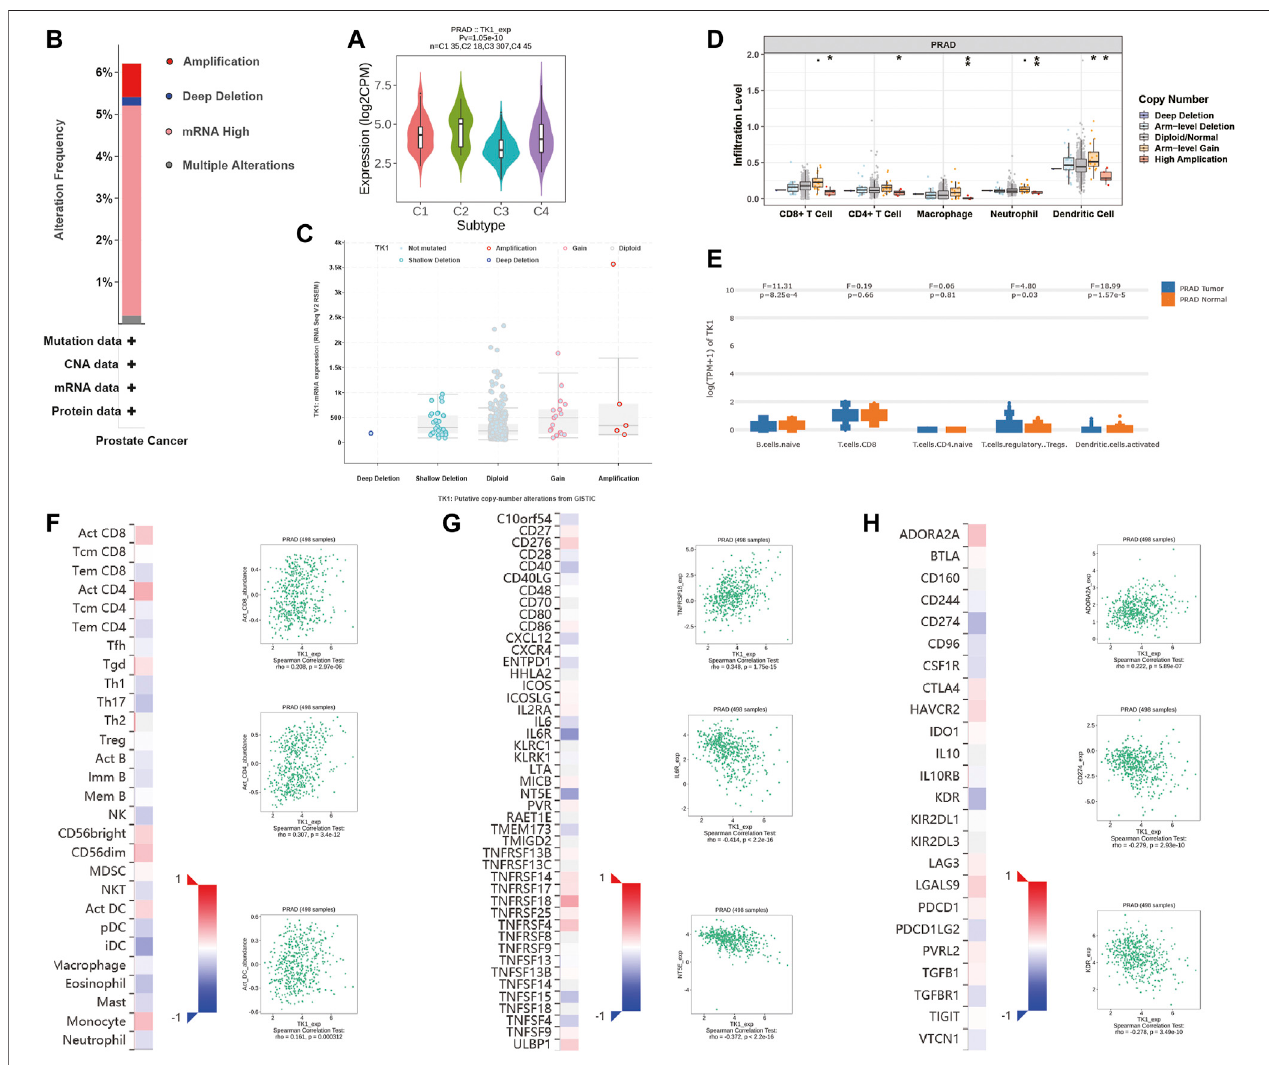
FIGURE 6 | Immune analysis of TK1 in PCa. (A) Relationships between TK1 expression and immune subtype in TCGA prostate cancer dataset. (B) The mutation types and mutation frequencies of TK1 in PCa. (C) Correlation between mRNA expression of TK1 and the copy number in PCa. (D) Correlation between TK1 copy number and tumor-in fi ltrating lymphocytes (TILs). (E) TK1 expression of immune cells in the prostate tumor and normal tissues. (F) Correlation between TK1expressionand TILs(TISIDB). (G,H) CorrelationbetweenTK1expressionand immunostimulators (G) and immunoinhibitors (H) . In theheatmapsof (F-H) , theredandbluesquaresrepresentpositiveandnegativecorrelations,respectively.ThescatterplotsshowTILsorimmunomodulatorswiththestrongestcorrelation with TK1 expression.